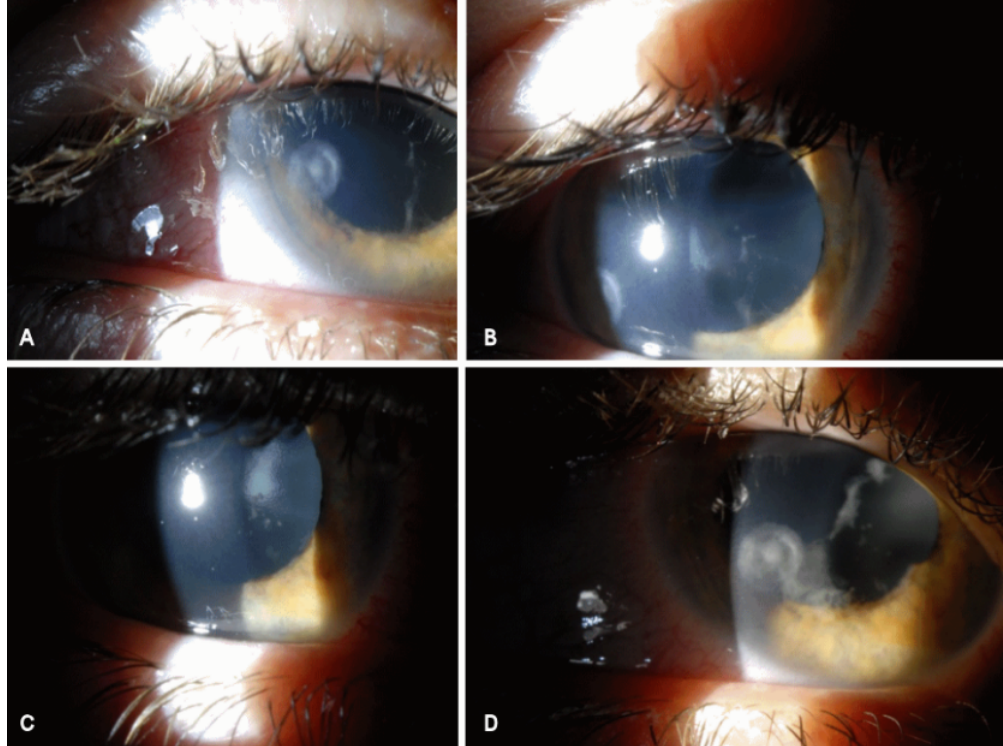
Figure 3: Progressive resolution of fungal mass during intracameral Amphotericin B treatment on day 7 (A/B), day 11 (C), and day 15 after its discontinuation